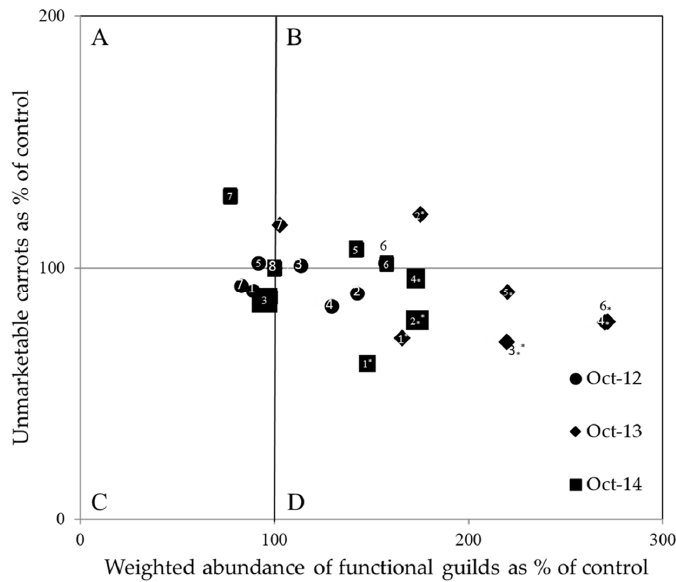
Figure 6. Integrated Production Efficiency (IPE) of amending sandy clay loam soil with either animal (AC) or plant (PC) based compost applied at 135, 203 or 270 kg N/ha on unmarketable carrot ( y -axis) and weighted abundance of functional guilds (WAFG, x -axis) of nematodes at harvest in October 2012 (Oct-12), 2013 (Oct-13) and 2014 (Oct-14) growing seasons fitted to the IPE model. Numbers 1–3 refer PC at a rate of 135, 203 and 270 kg N/ha, respectively and 4–6 refer AC at a rate 135, 203 and 270 kg N/ha, respectively, 7 and 8 refer urea and non-amended check, respectively. * Treatments with subscripts and superscripts asterisks (*) indicate significantly different form 100% for WAFG and unmarketable carrots, respectively, using one-tailed t-test at α = 0.05. The soil amendment rates and the unmarketable carrot data presented here are the same as those in Table S4. The WAFG data presented here are the same as those in Table 1. Table 1. Effects of amending sandy clay loam soil with either animal (AC) or plant (PC) based compost applied at 135, 203 or 270 kg N/ha planted with processing cultivar on weighted abundance of functional guilds (WAFG) as percent of untreated control at planting (0) and at harvest during 2012–2014 growing seasons. Untreated check and urea containing standard N rate of 135 kg N/ha served as controls. The harvest dates were 132 in 2012 and 133 DAP in 2013 and 2104.